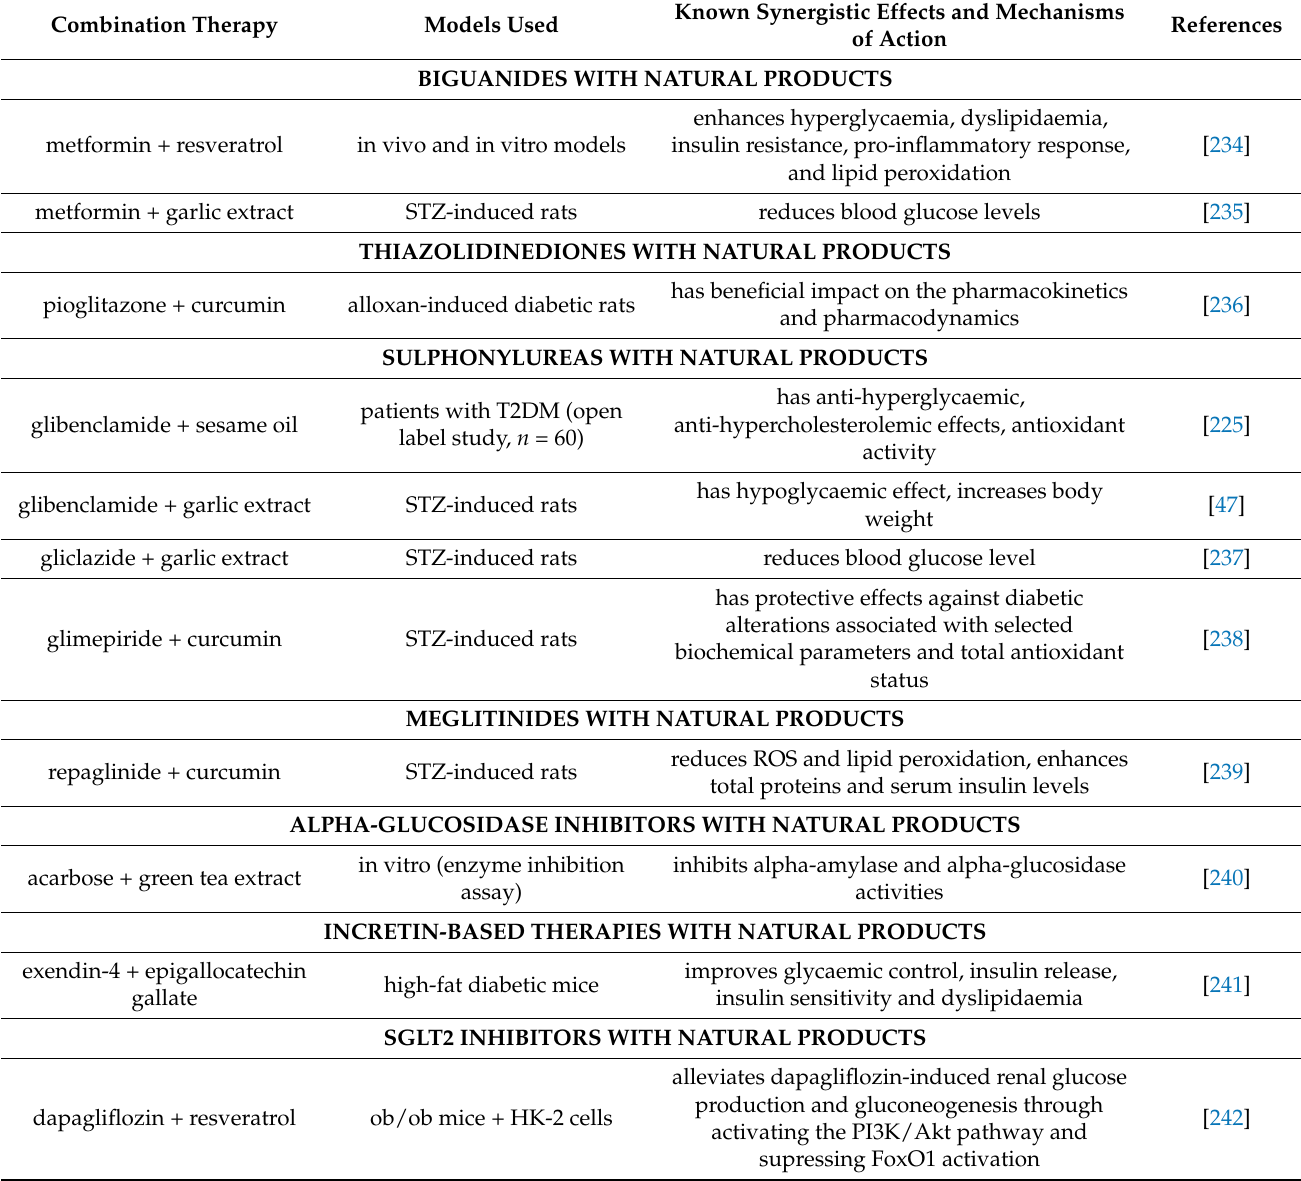
Table 2. List of all combination therapies reported in this